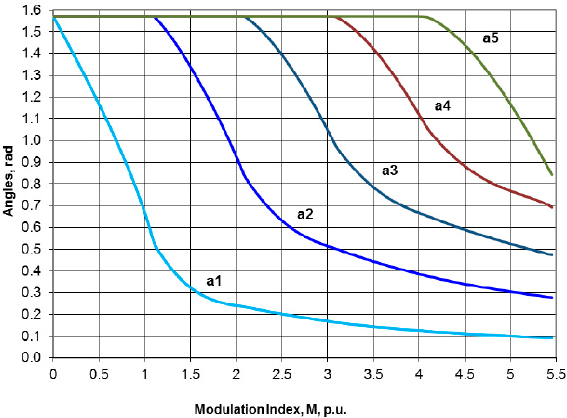
Figure 4. Voltage optimal switching angles for n = 5 (up to 11 voltage levels).